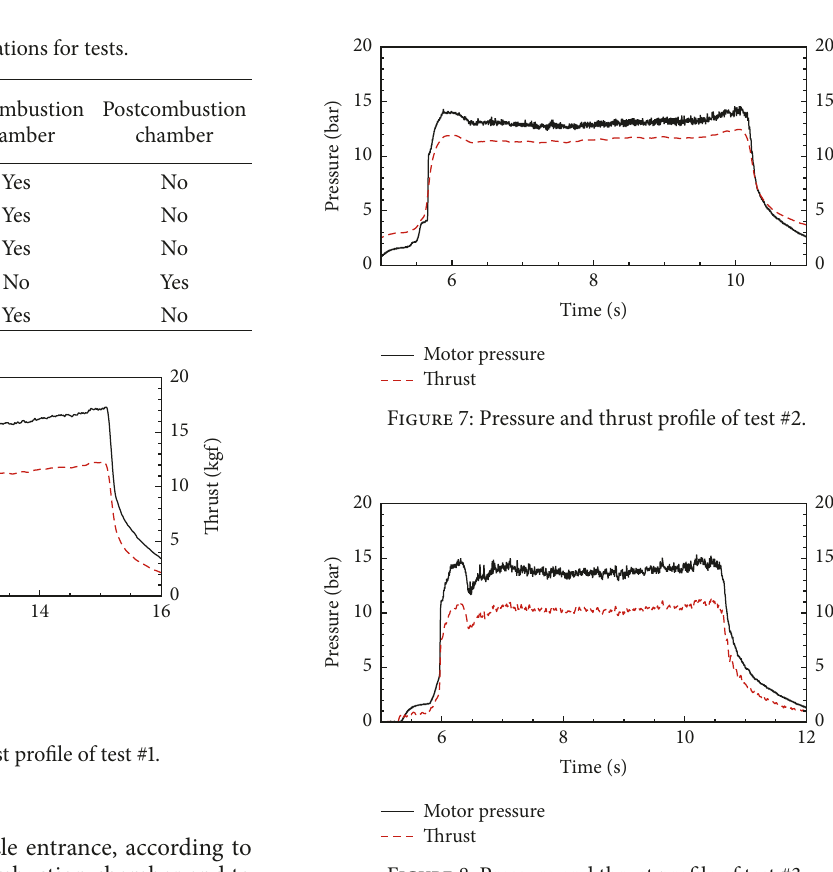
Figure 8: Pressure and thrust profile of test #3.